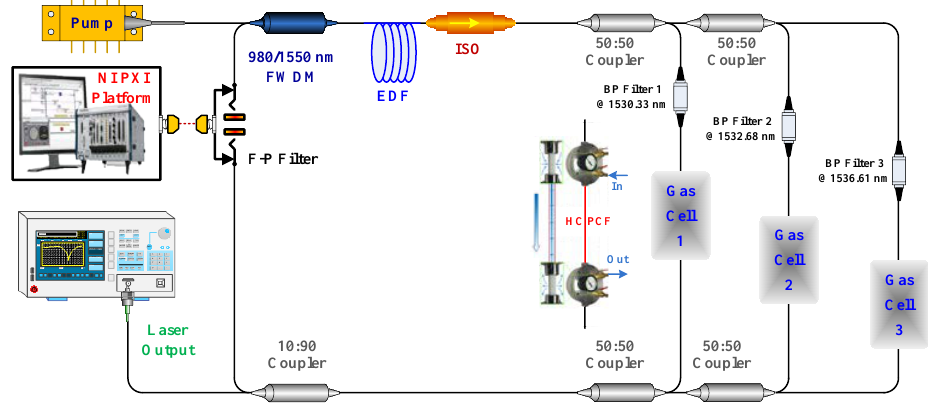
Figure 10. Multipoint sensing system based on intracavity spectroscopy technology (ICST).